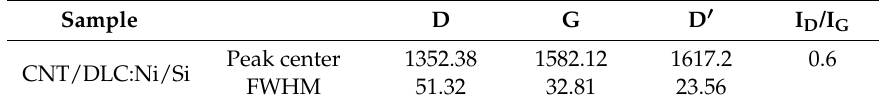
Figure 3. Raman spectroscopy of CNT produced by chemical vapor deposition (CVD). Table 1. Peak position, FWHM, and intensity of D and G bands (I D /I G ) ratios for the CNT film.